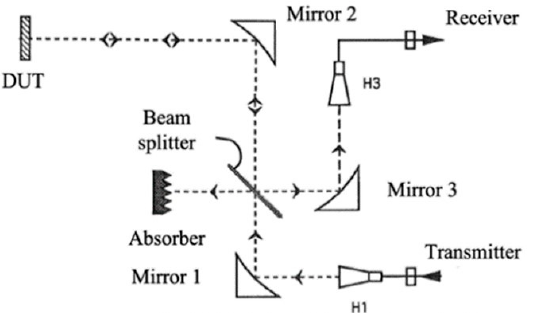
Figure 6. Schematic view of the mm-wave absorption measurement setup for coated disks [14].